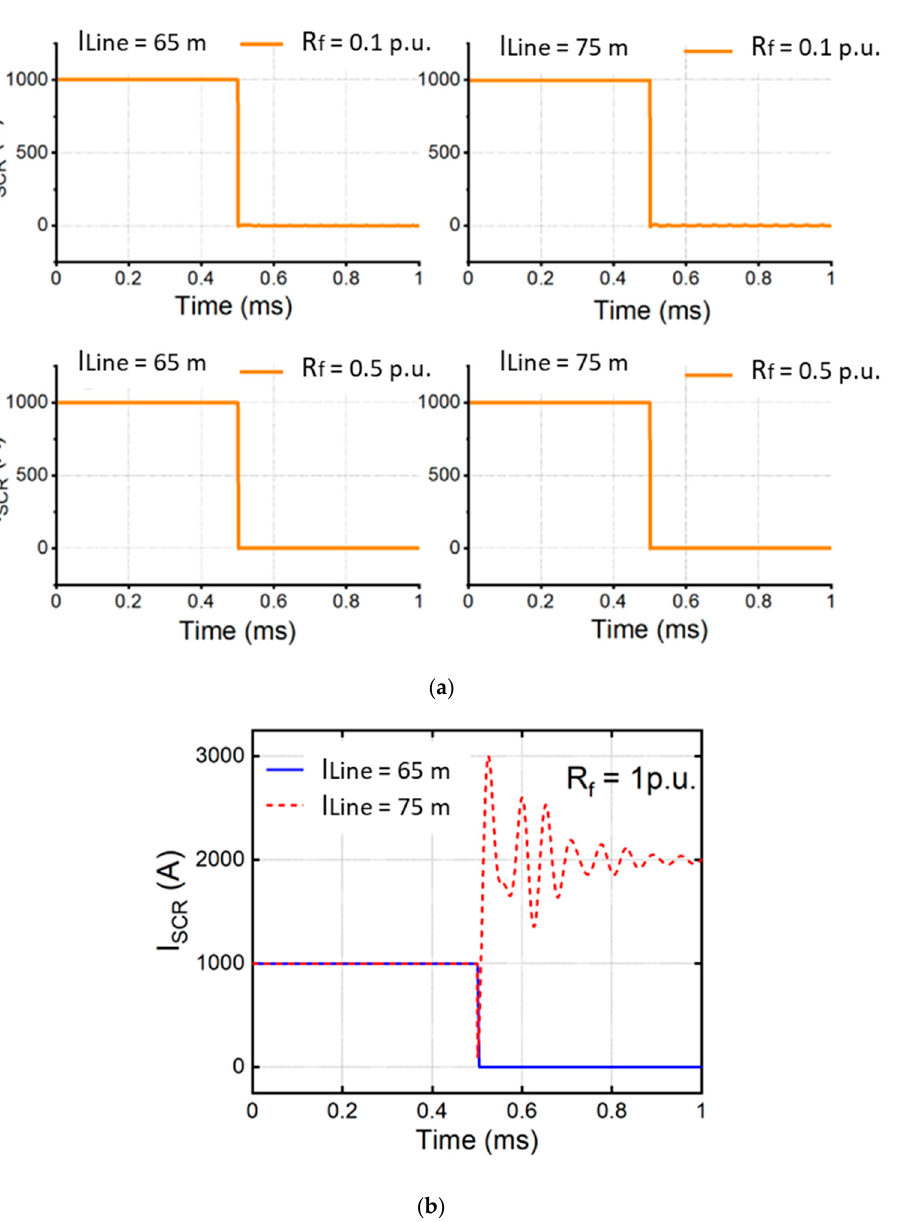
Figure 2. Performance of ZCB under different fault current levels, comparing cable lengths of 65 and 75 m: ( a ) R f = 0.1 p.u.